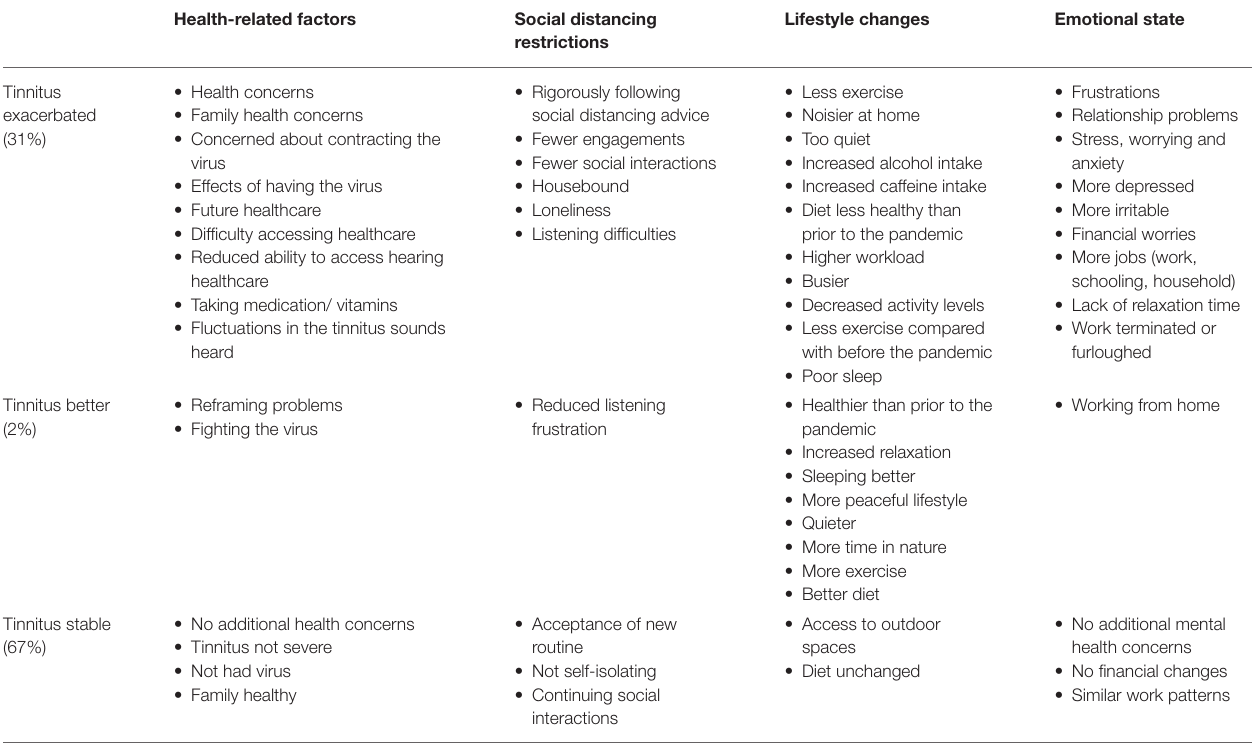
TABLE 1 | Factors related to tinnitus being stable, better, or exacerbated during the pandemic that were identified through thematic qualitative analysis of free text